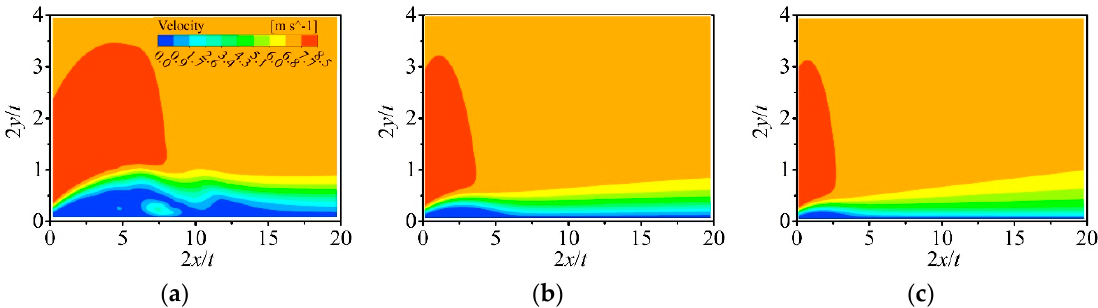
Figure 11. The velocity contour near the leading edge area of the basic elliptical shape at different turbulence values : ( a ) At Tu = 0; ( b ) At Tu = 5%; ( c ) At Tu = 7%.